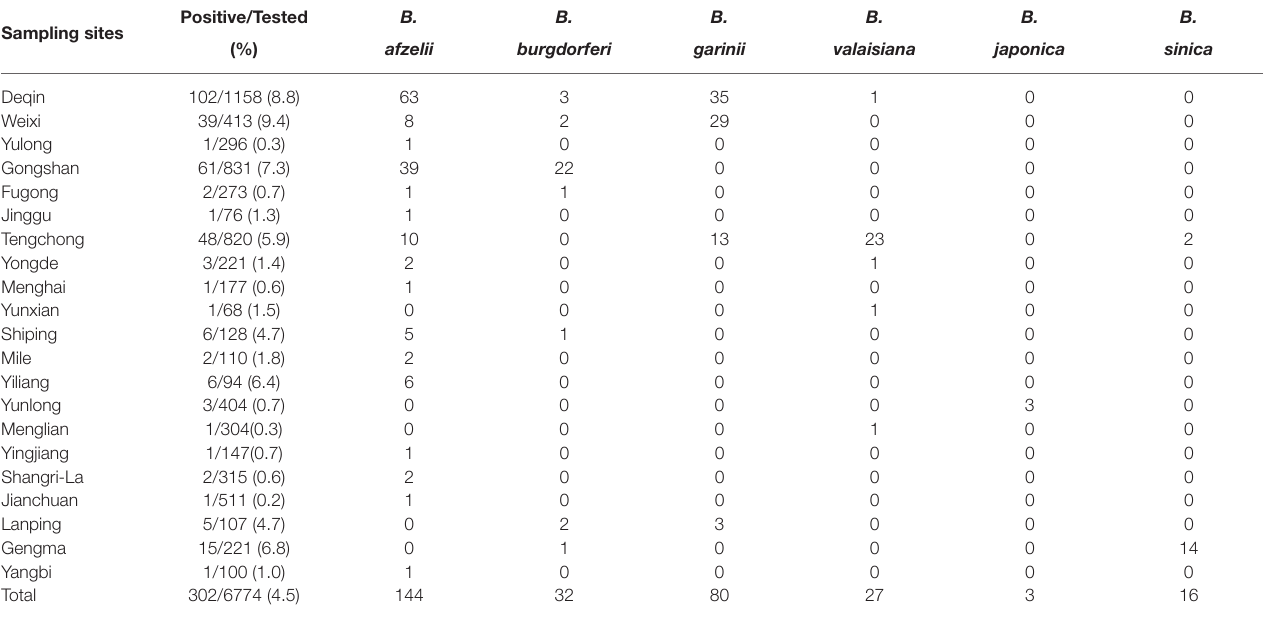
TABLE 3 | Results of Genotypes of BBSL in 21 positive sampling